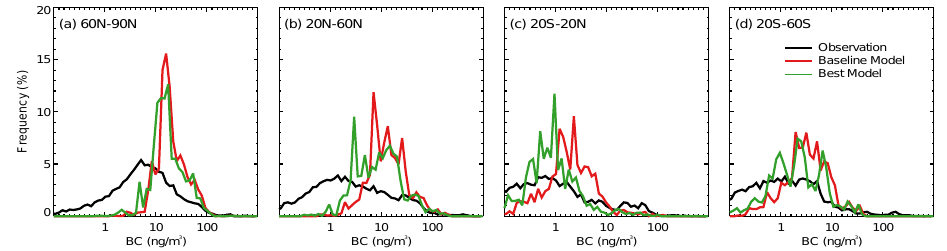
Figure 3. Frequency distribution of observed (black) and “baseline” (red) and “best” (green) simulated black carbon concentrations during all five HIPPO campaigns from 2009–2011, shown by region.